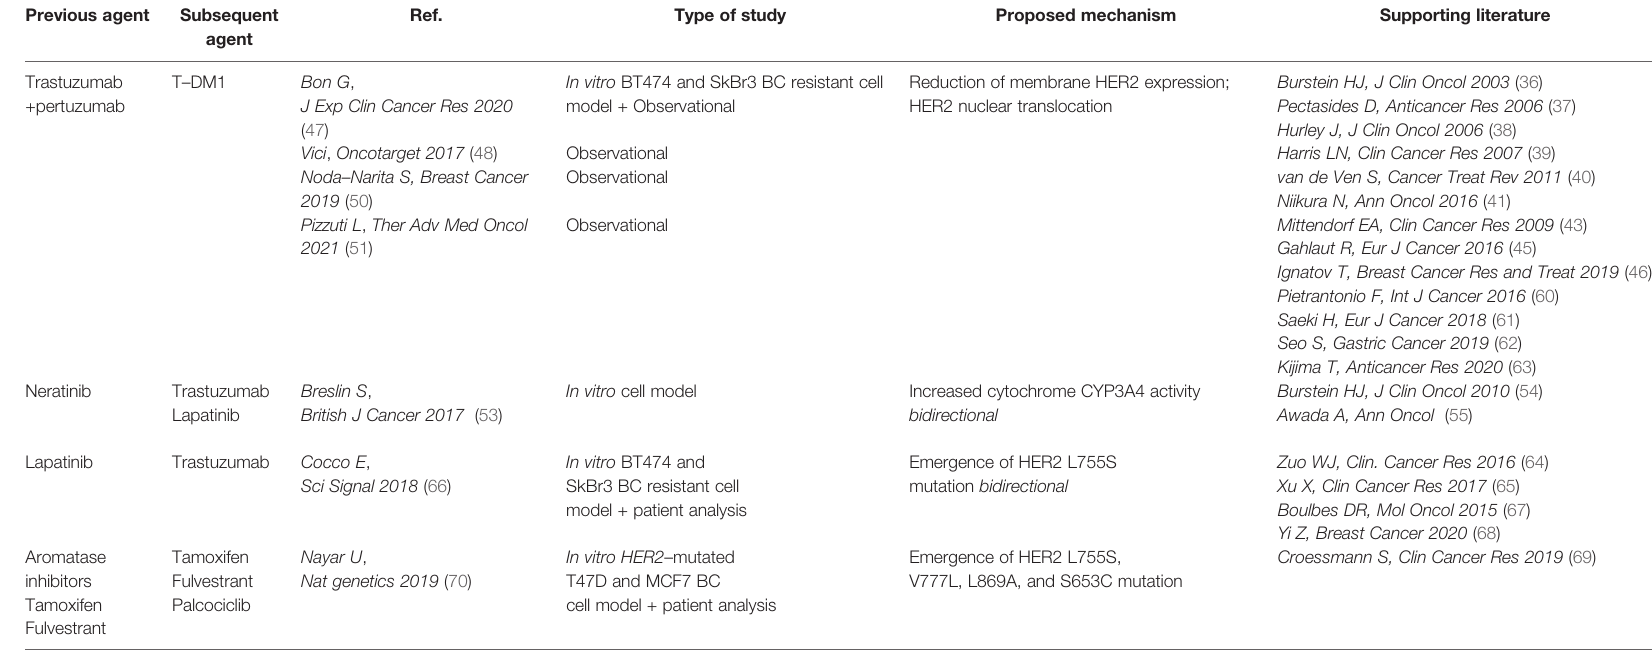
TABLE 1 | Cross – resistance in HER2 – and ER – targeted